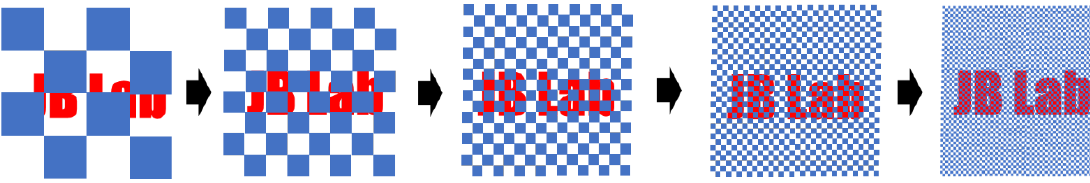
Figure 3. Difference in transmittance according to the change in pattern size change (total aperture ratio is the same as 50%).